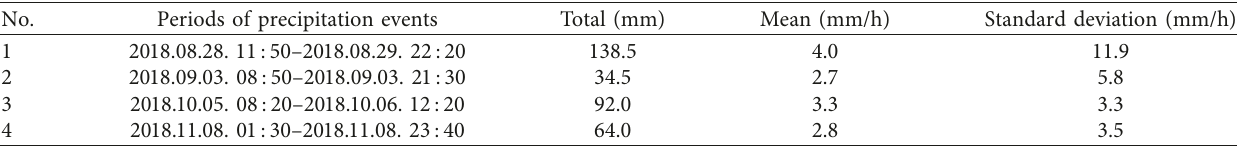
Table 2: Precipitation events selected based on observed rainfall data from Seoul